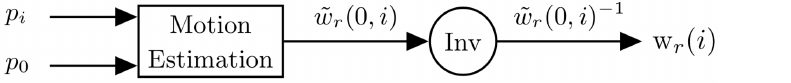
Figure 2. Typical registration procedure. “Inv” corresponds to an inversion in the space of warp- ing